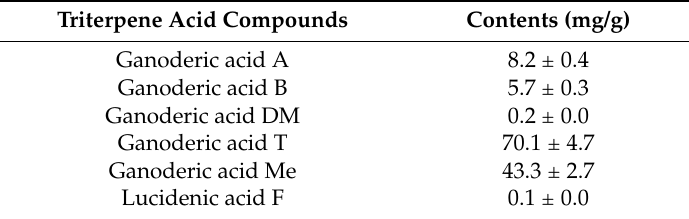
Table 1. Triterpene acid compound contents of the triterpene acid extract (TAE) from G. lingzhi mycelium.